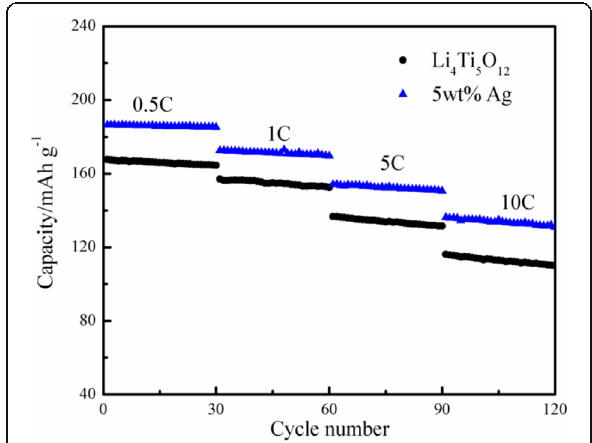
Fig. 5 Rate capability of the Ag-free and the 5 wt.% Ag-coated Li 4 Ti 5 O 12 under different current